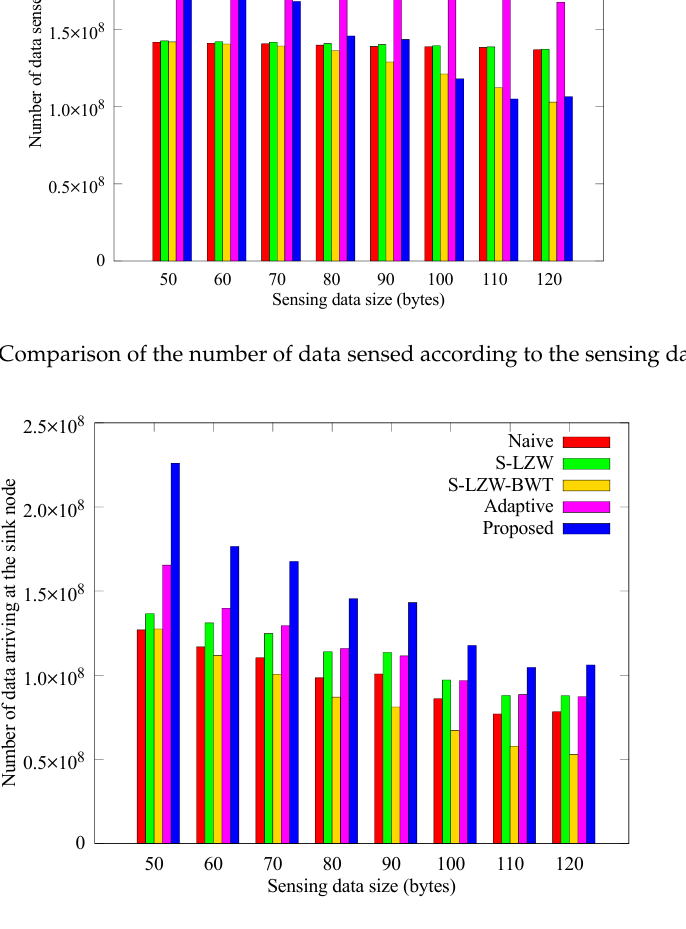
Figure 13. Comparison of the number of data obtained according to the sensing data